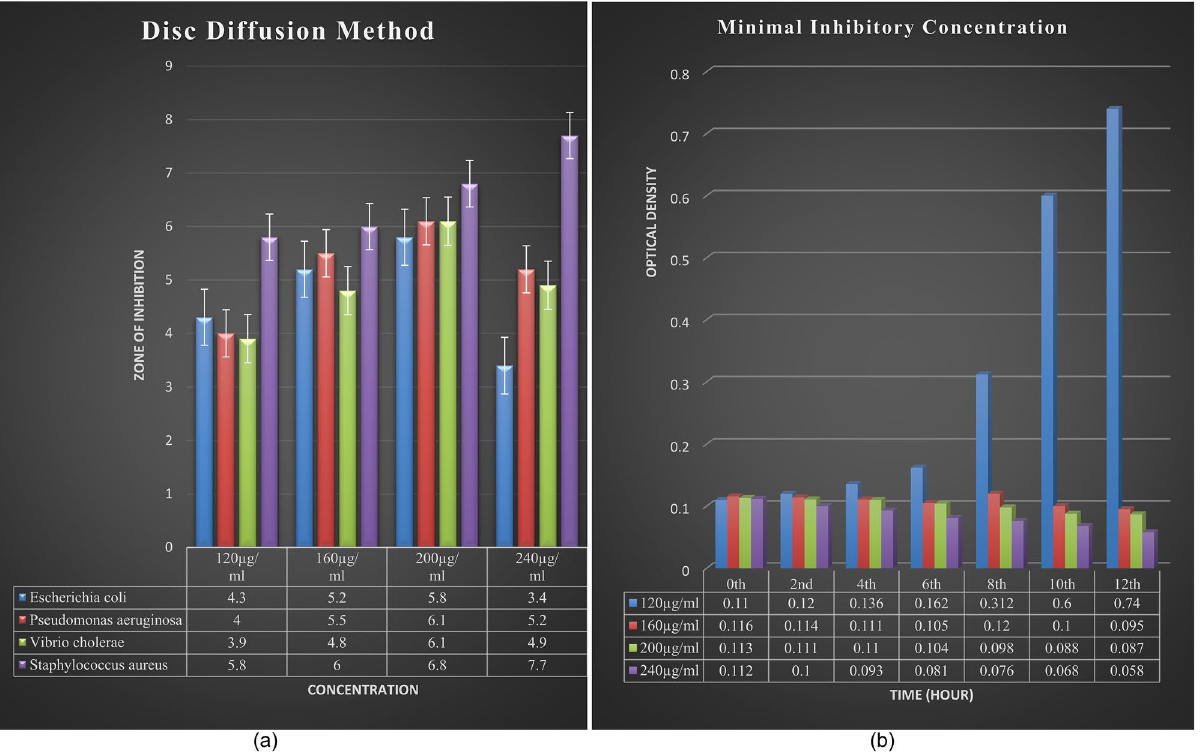
Figure 5. ( a ) Antimicrobial activity test by Disc Diffusion Method against different bacterial strains, ( b ) Minimal Inhibitory Concentration test on S. aureus.